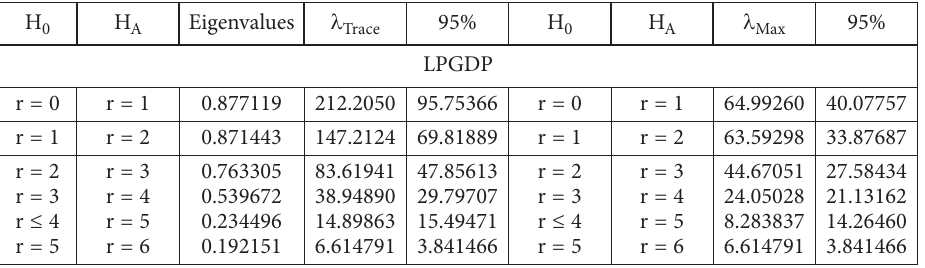
Table 4. Johansen co-integration test (lags = 3) H